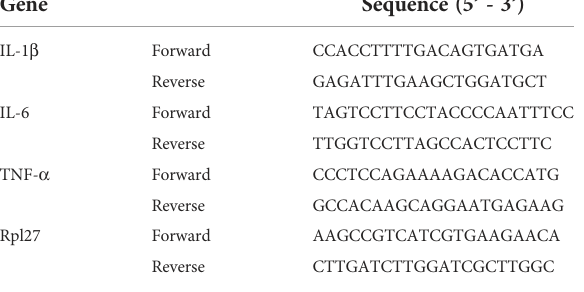
TABLE 1 Primer sequences of IL-1 b , IL-6, TNF- a and Rpl27.